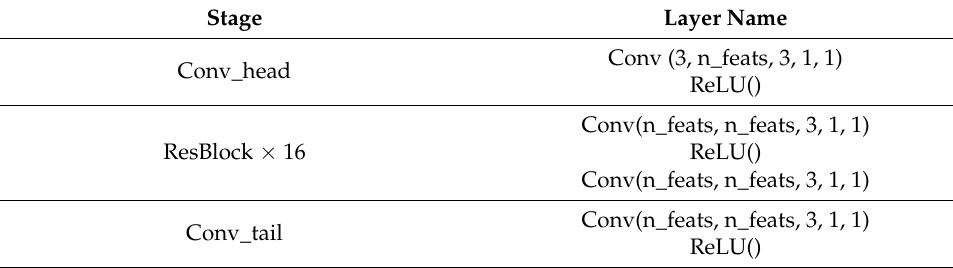
Table A2. The detailed structure of EN.